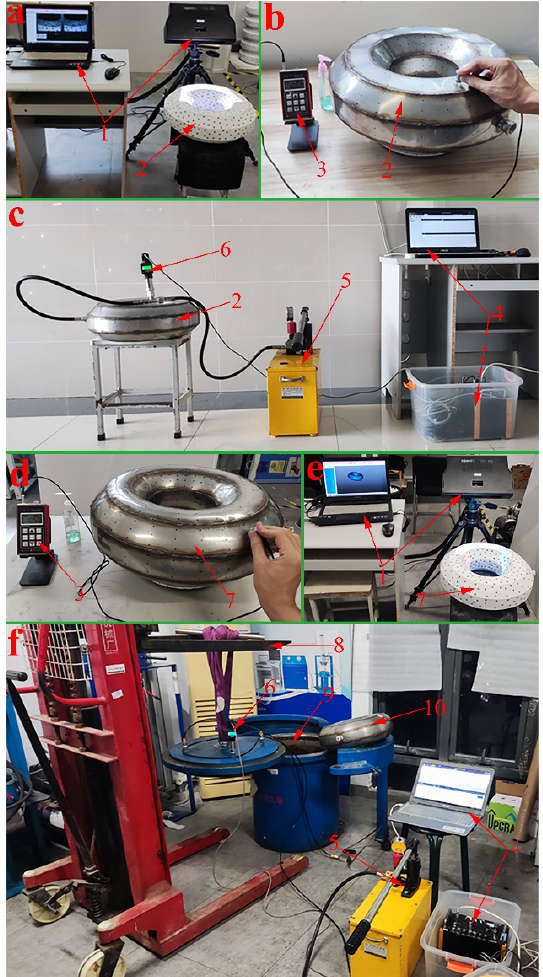
Figure 12. Experimental flowchart of toroidal pressure hull: ( a ) surface scanning of preformed toroid, ( b ) thickness measuring of preformed toroid, ( c ) internal hydroforming of preformed toroid, ( d ) thickness measuring of hydroformed toroid, ( e ) surface scanning of hydroformed toroid, and ( f ) hydrostatic testing of hydroformed toroid.